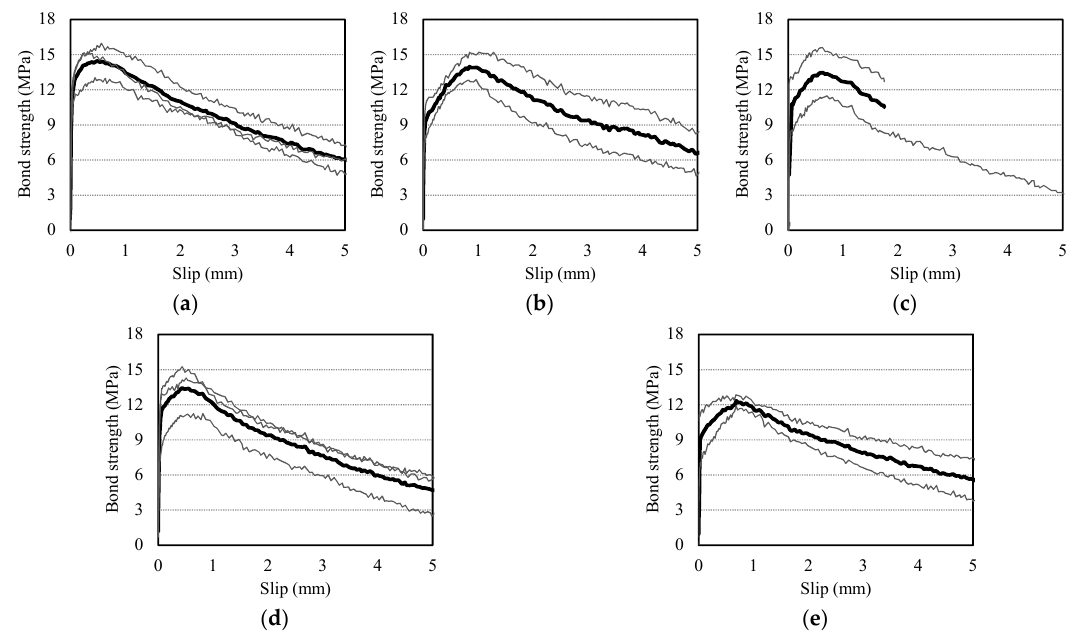
Figure 4. Bond strength-slip curves of V-type specimens. ( a ) G0F0V; ( b ) G15F60V; ( c ) G30F45V; ( d ) G45F30V; ( e ) G60F15F. Table 5. Bond strength of V-type specimens at 28 days.